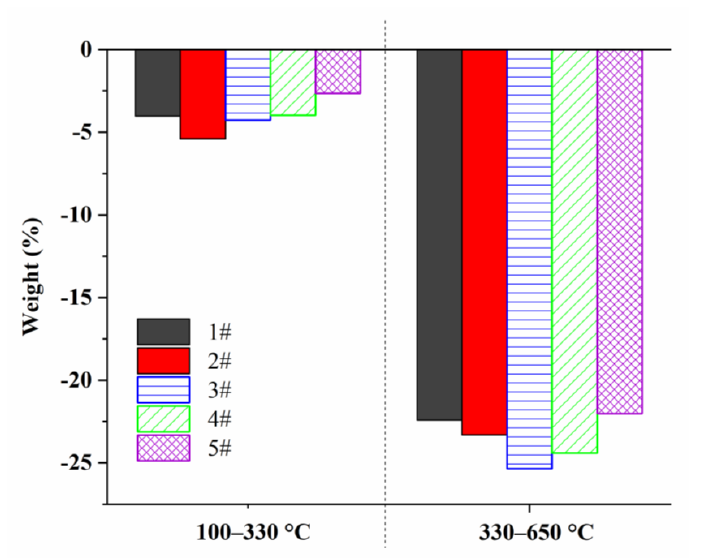
Figure 11. Thermal weight loss rate in the first and second stages for 1#–5# pre-oxidized